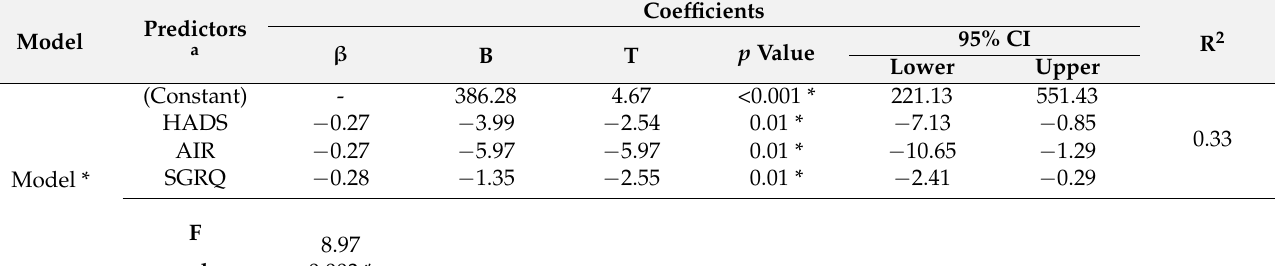
Table 4. Multiple linear regression analysis for the 6 MWT distance as dependent